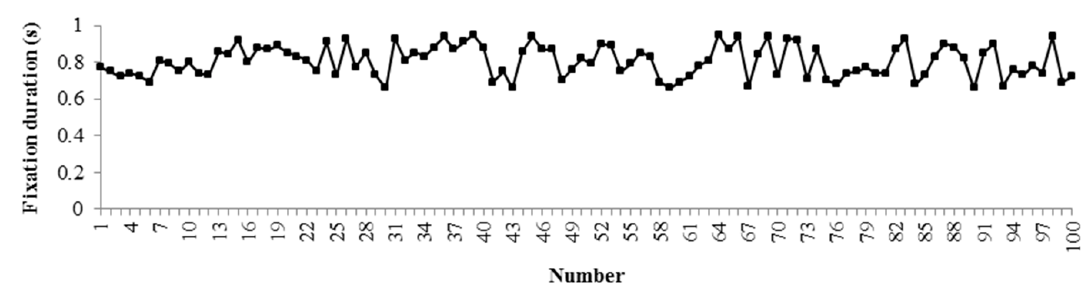
Figure 8. Drivers’ fixation count in anxiety.